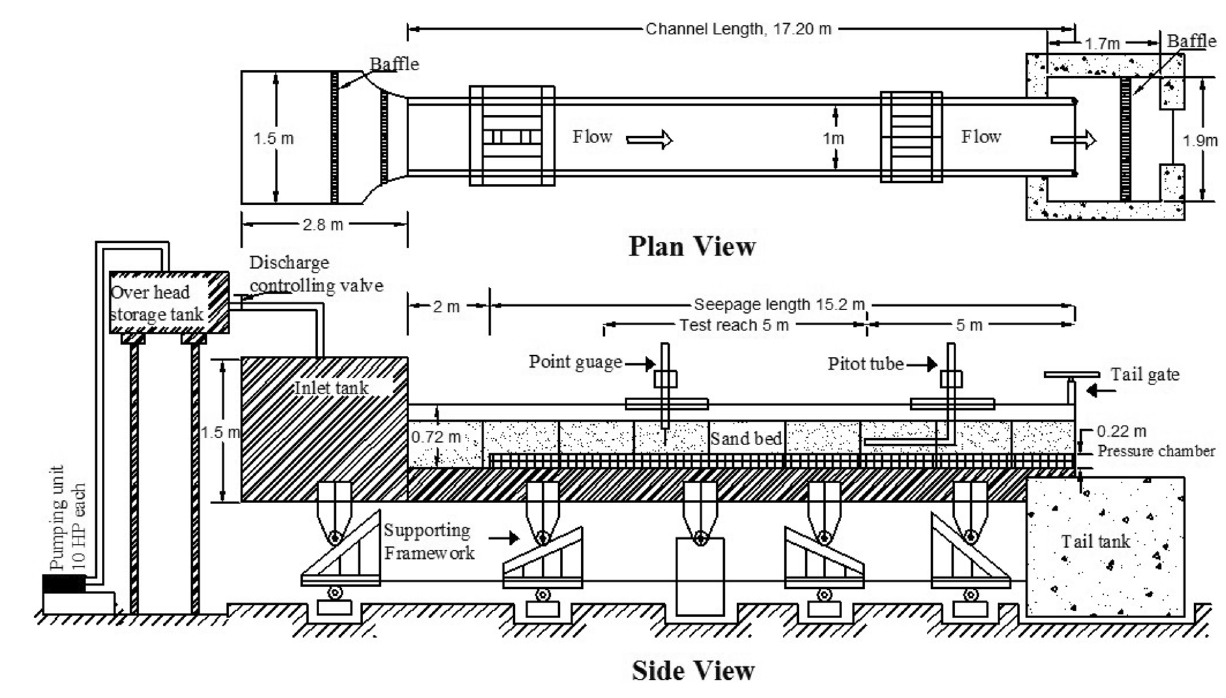
Figure 1. Schematic diagram of the experimental